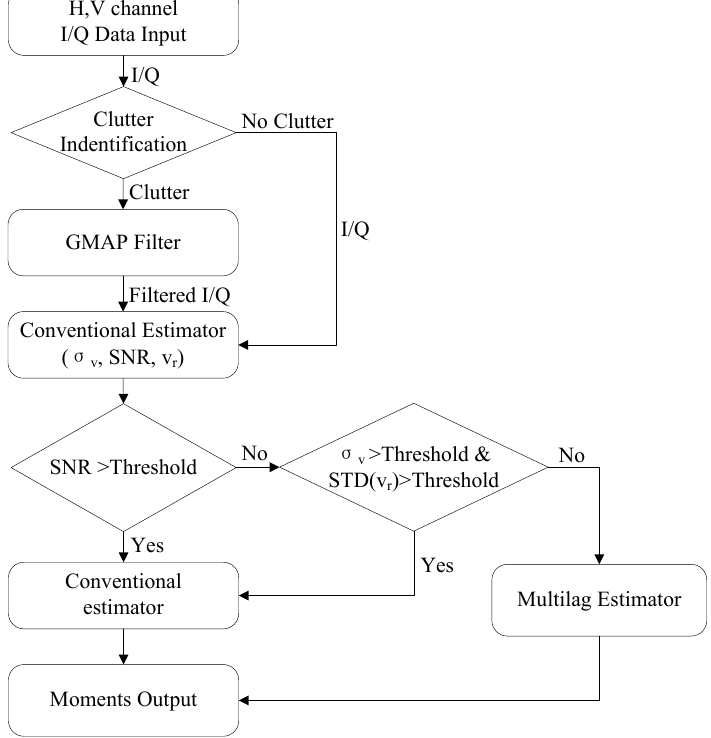
Figure 12. Flowchart of the hybrid algorithm.